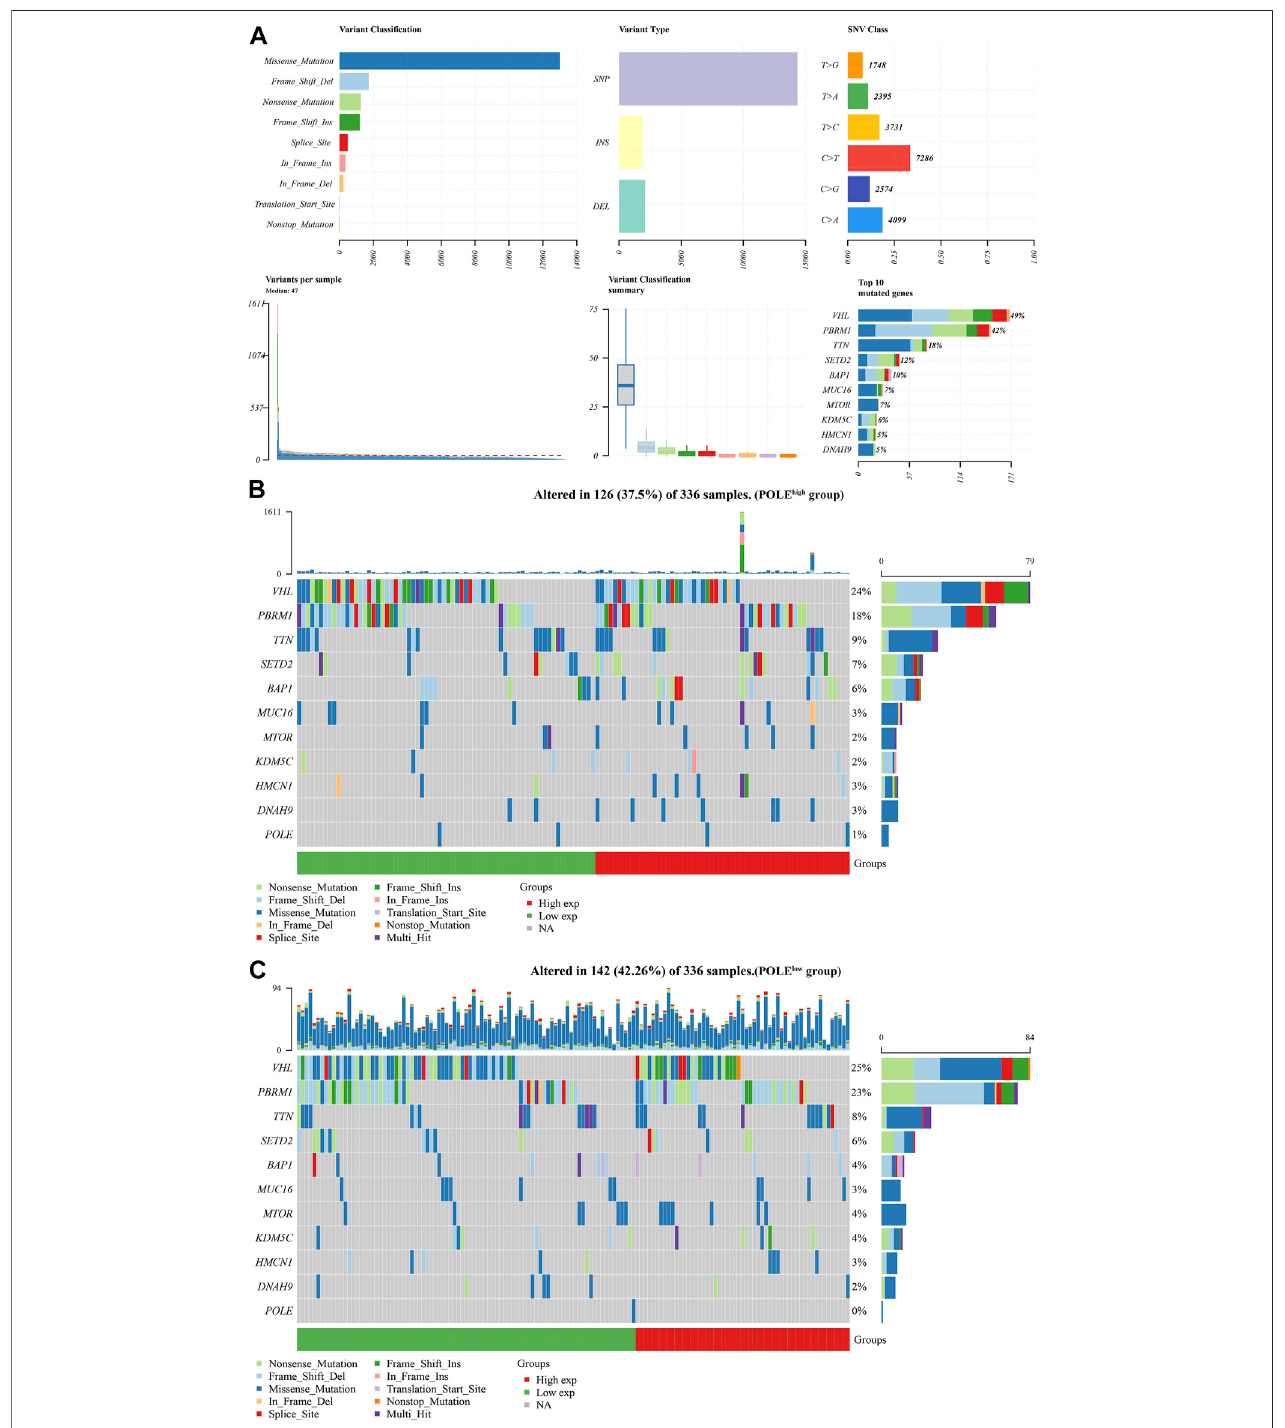
FIGURE 5 | Differential mutation landscape between different polymerase epsilon (POLE) expression pro fi les in clear cell renal cell carcinoma (ccRCC). (A) The variant classi fi cations, variant types, and single-nucleotide variant (SNV) classes ofPOLE aresummarized. SNVs ofthetop 11mutated POLEgenes. (B,C) Thesomatic landscapesofcellswithhighandlowPOLEexpression,withthetop10genesorderedaccordingtomutationfrequency.Inparticular,thePBRM1mutationratewas23% in the POLE low group vs. 18% in the POLE high group.